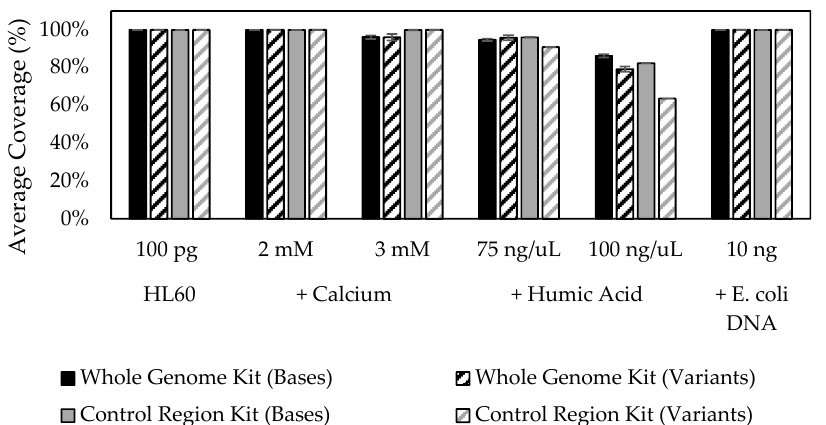
Figure 7. Stability studies: chemical insults and coverage with control region and mtGenome multiplexes. Stability studies were conducted, as described in Materials and Methods, by assessing effects on average coverage (%, y -axis) of PCR in-